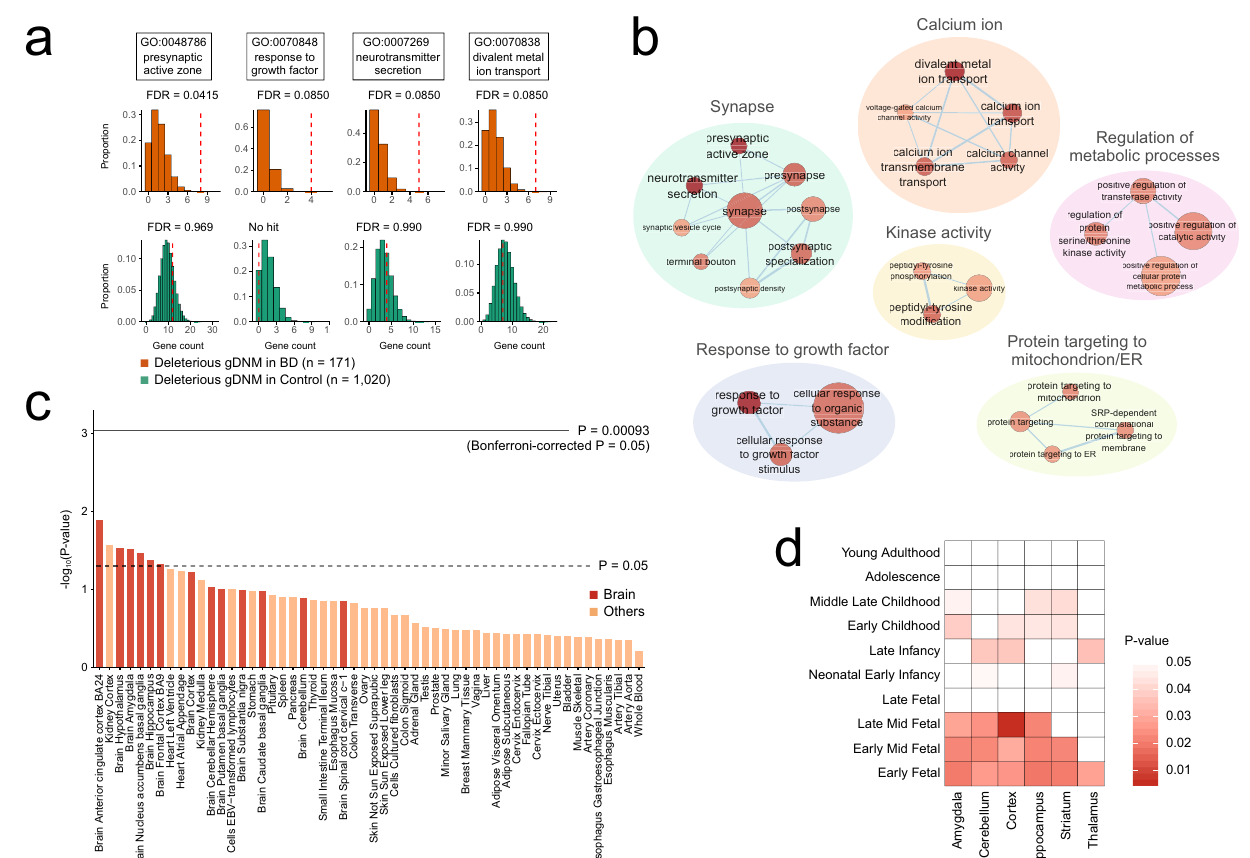
Fig. 2 Gene set enrichment analysis of deleterious gDNMs in BD. a Gene ontology (GO) terms enriched among the genes hit by deleterious (LoF or damaging missense/inframe indel) gDNMs in BD at a false discovery rate (FDR) <0.1. FDR adjustment was performed based on the number of terms in the corresponding GO category (biological process, cellular component, or molecular function). Uncorrected P values for our observations (the red dotted lines) were calculated by DNENRCIH that considers confounding factors, such as gene sizes and local sequence contexts ( “ Methods ” ). The histograms indicate the distributions of the expected number of gDNMs hitting the corresponding GO term (the x axis), which was generated by one million random permutations by DNENRCIH. Top, BD; bottom, controls. b Network visualization of the GO terms enriched among the genes hit by deleterious gDNMs in BD at uncorrected P < 0.05. The node colors and label sizes indicate the statistical signi fi cance of enrichment (deep red indicates the most signi fi cant terms). The node sizes indicate the number of genes included in a term. The edge width is proportional to the overlap coef fi cient. The full list of GO terms with uncorrected P < 0.05 is shown in Supplementary Data 2. c Enrichment analysis of the genes hit by deleterious gDNMs in BD for the top 2% of the genes with the highest expression in each of the 54 human tissues in the GTEx dataset. Uncorrected P values calculated by DNENRICH are shown as bar plots. The dotted and solid lines indicate the nominal ( P = 0.05) and the Bonferroni-corrected ( P = 0.00093 = 0.05/54) signi fi cance threshold, respectively. Bars are color coded as shown on the lower right of the plot. d Enrichment analysis of the genes hit by deleterious gDNMs in BD for the top 2% of the genes with the highest expression in each developmental period of a brain region in the BrainSpan Human Developmental Transcriptome dataset. Cells are color coded by uncorrected P values calculated by DNENRICH as shown on the right of the grid